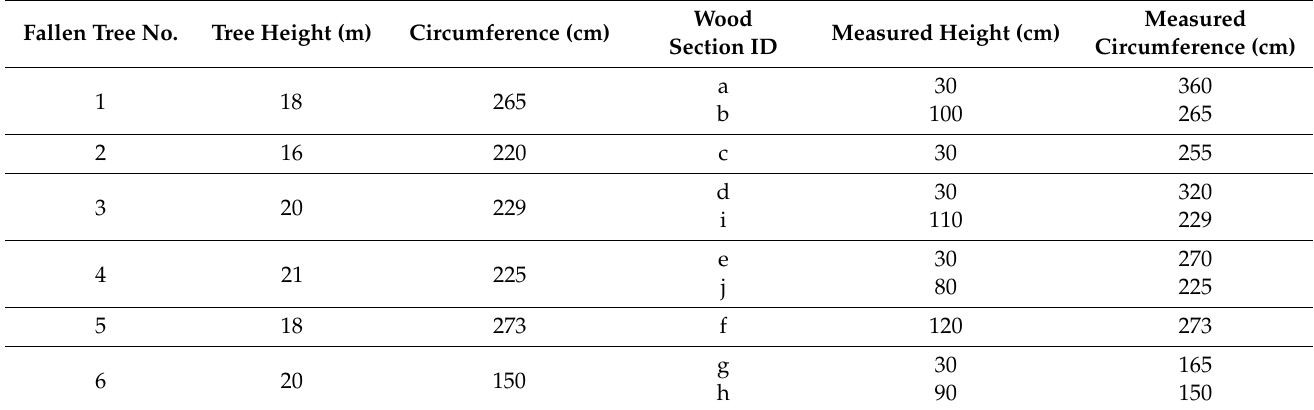
Table 1. The list of fallen